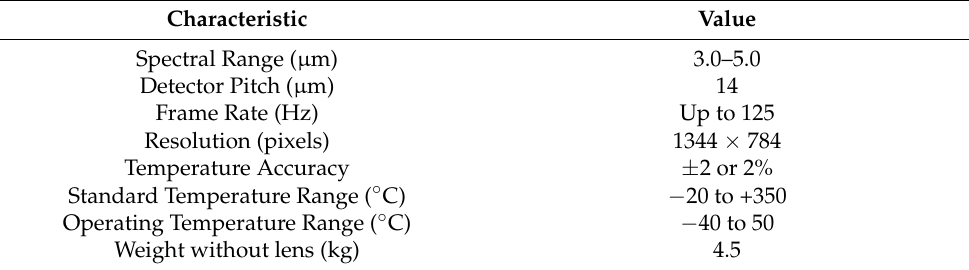
Table 2. Summary of key characteristics of the SC8303 FLIR MWIR sensor.